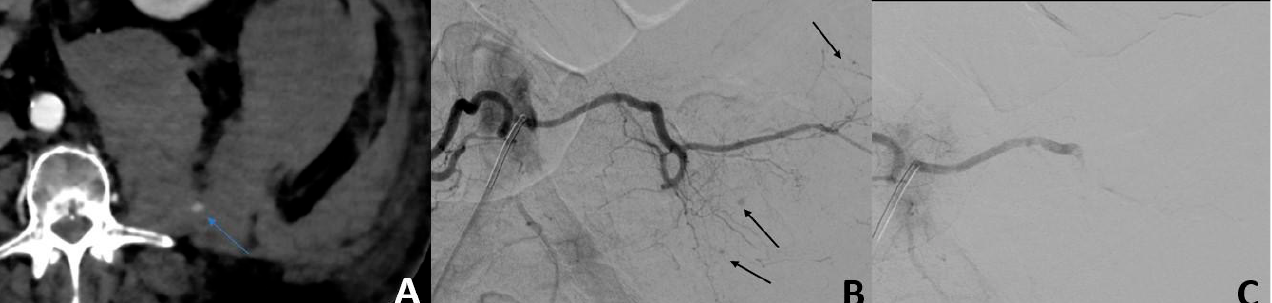
Figure 1. Isolated blood loss in a 74-year-old patient 2 days after cardiac surgery. ( A ) The MDCT scan showed active bleeding (blue arrow) from a large left retroperitoneal hematoma. ( B ) Angiography confirmed active multifocal bleeding from the left L5 lumbar artery (black arrows). ( C ) After embolization with NBCA, the control showed no opacification of the distal branches of the left L5 lumbar artery.